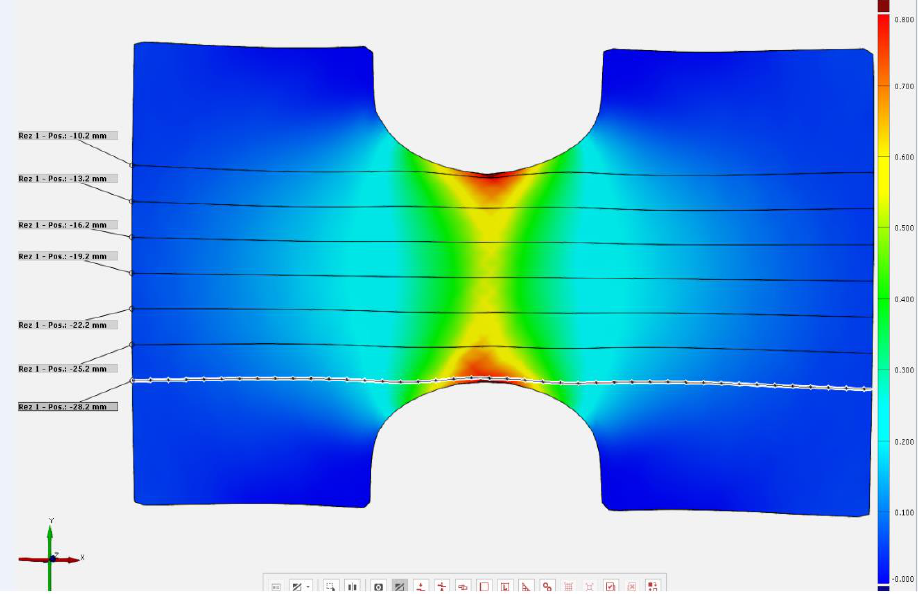
Figure 5. Sample image from ARAMIS measuring system with notch radius of R5 mm after strain has occurred.